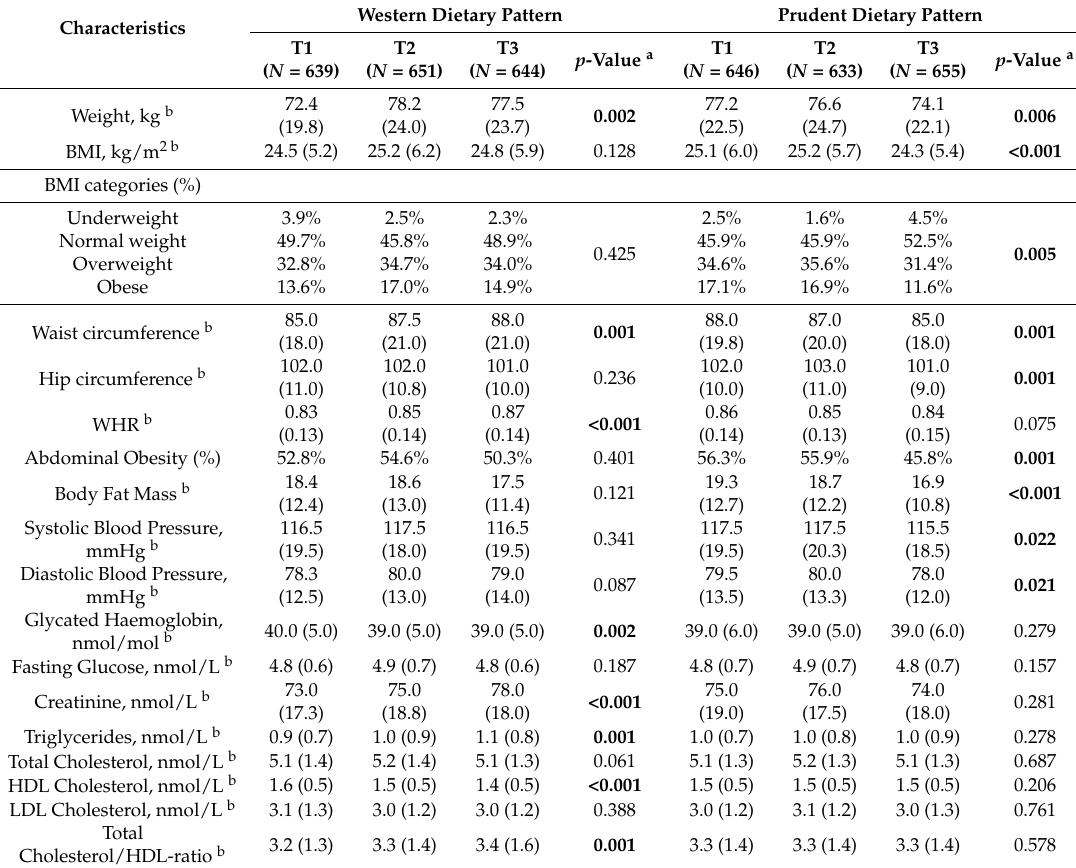
Table 3. Cardio-metabolic parameters of study participants by tertiles of dietary